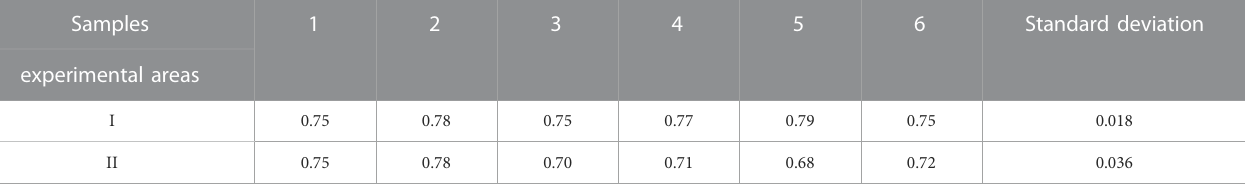
TABLE 7 Standard deviation based on IAs of each data in experimental area I and II.